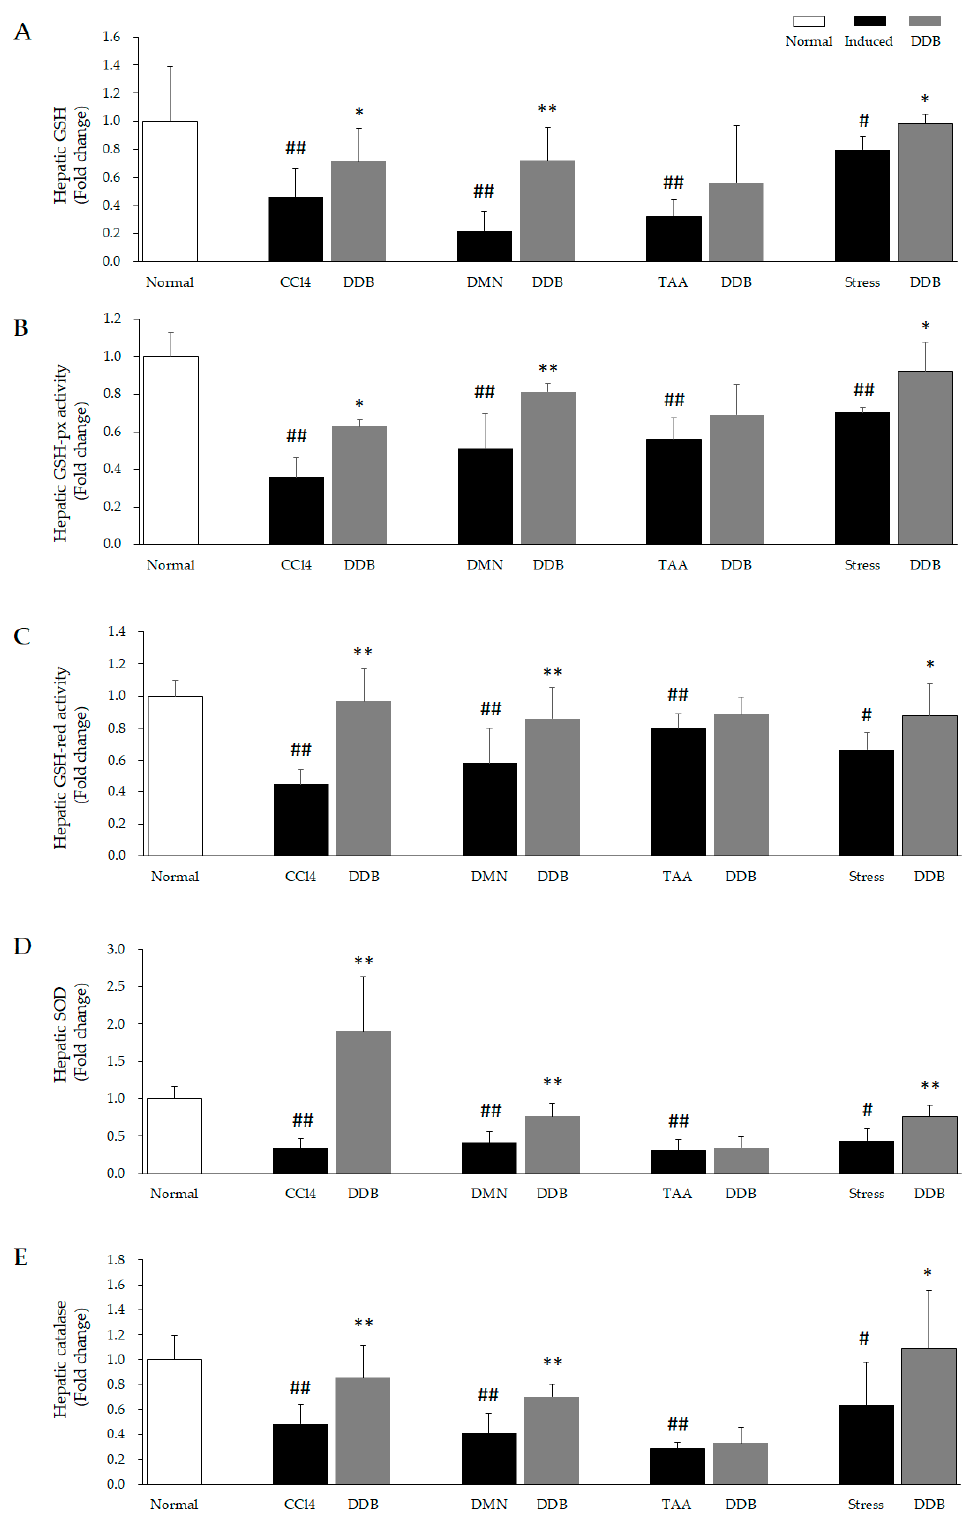
Figure 4. Comparison of the main hepatic antioxidative parameters in four liver injury models. Five main antioxidative parameters, GSH ( A ), GSH-px ( B ), GSH-red ( C ), SOD ( D ), and catalase ( E ), were determined in prepared liver tissue samples, as described in the Materials and Methods section. # p < 0.05 and ## p < 0.01 compared with the normal group. * p < 0.05 and ** p < 0.01 compared with the corresponding control.